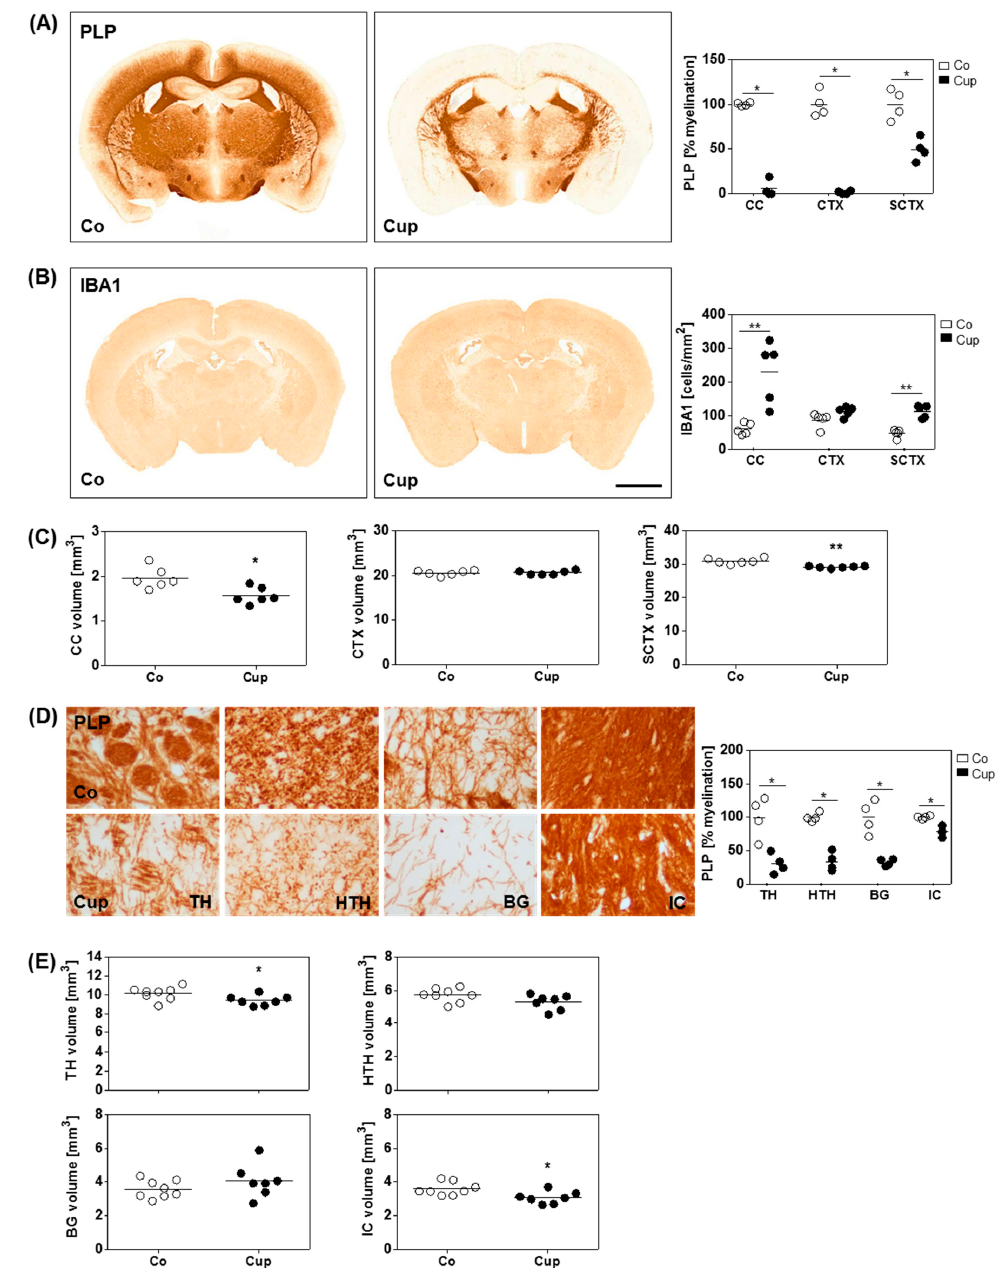
Figure 3. Chronic demyelination leads to subcortical volumetric reduction. ( A ) Quantification of myelination (anti-PLP) and ( B ) microgliosis (anti-IBA1) in the medial corpus callosum (CC), cortex (CTX), and subcortical area (SCTX) from controls (Co) ( n = 4) and five weeks of cuprizone-intoxicated (Cup) mice ( n = 5). ( C ) Volumes of the CC, CTX, and the SCTX of Co ( n = 6) and Cup mice ( n = 6) analyzed with design-based stereology. ( D ) Quantification of myelination with representative pictures of individual subcortical regions (thalamus (TH), hypothalamus (HTH), basal ganglia (BG), internal capsule (IC)) from Co ( n = 4) and Cup mice ( n = 4). ( E ) Volumes of the TH, HTH, STR, and IC of Co ( n = 8) and Cup mice ( n = 7). Data are shown as individual values and means per group (lines). Statistical analysis revealed significant differences between Co and Cup in ( A) (CC, p = 0.03, CTX, p = 0.03, SCTX, p = 0.03), ( B) (CC, p = 0.008; SCTX, p = 0.008), ( C ) (CC, p = 0.02; SCTX, p = 0.0012), ( D ) (TH, p = 0.03; HTH, p = 0.03; BG, p = 0.03; IC, p = 0.03), and E (TH, p = 0.04; IC, p = 0.02); * p < 0.05, ** p < 0.01. Scale bar in ( B ) = 2 mm ( A , B ) and 17 µ m ( D